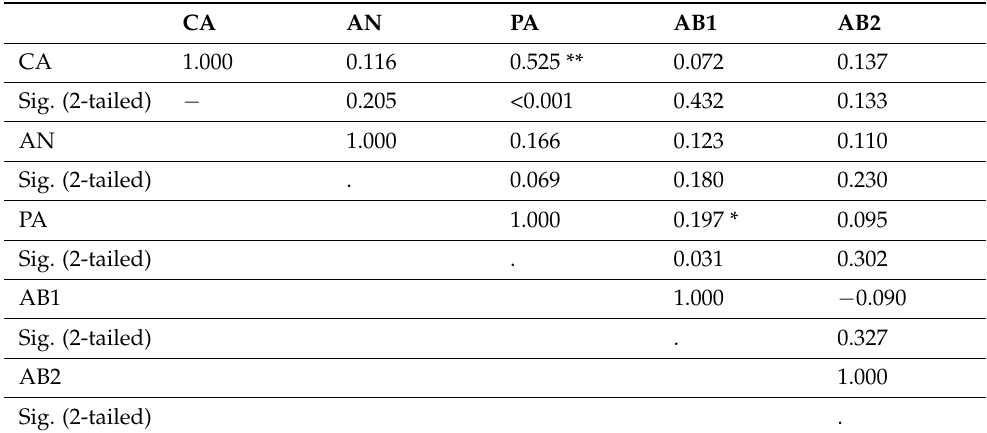
Table 2. Results of the correlation